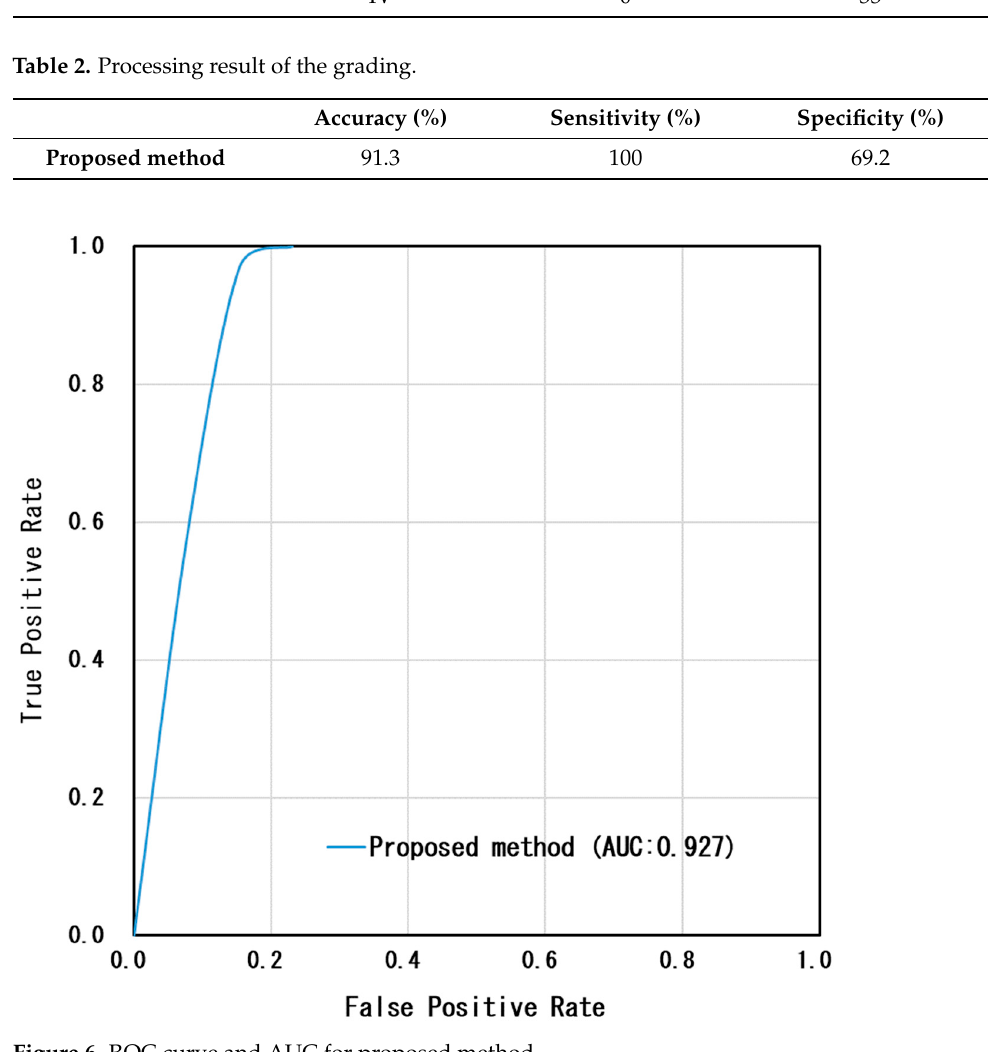
Figure 6. ROC curve and AUC for proposed method.